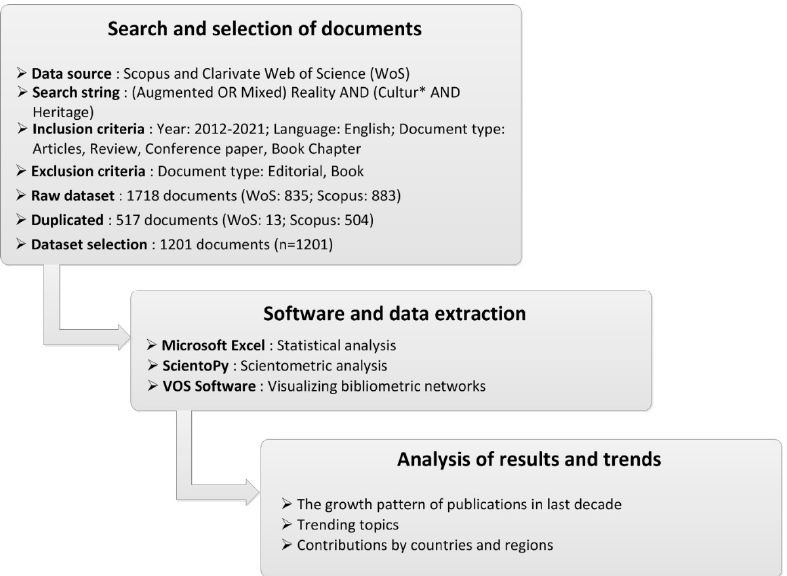
Figure 1. The methodology used in this